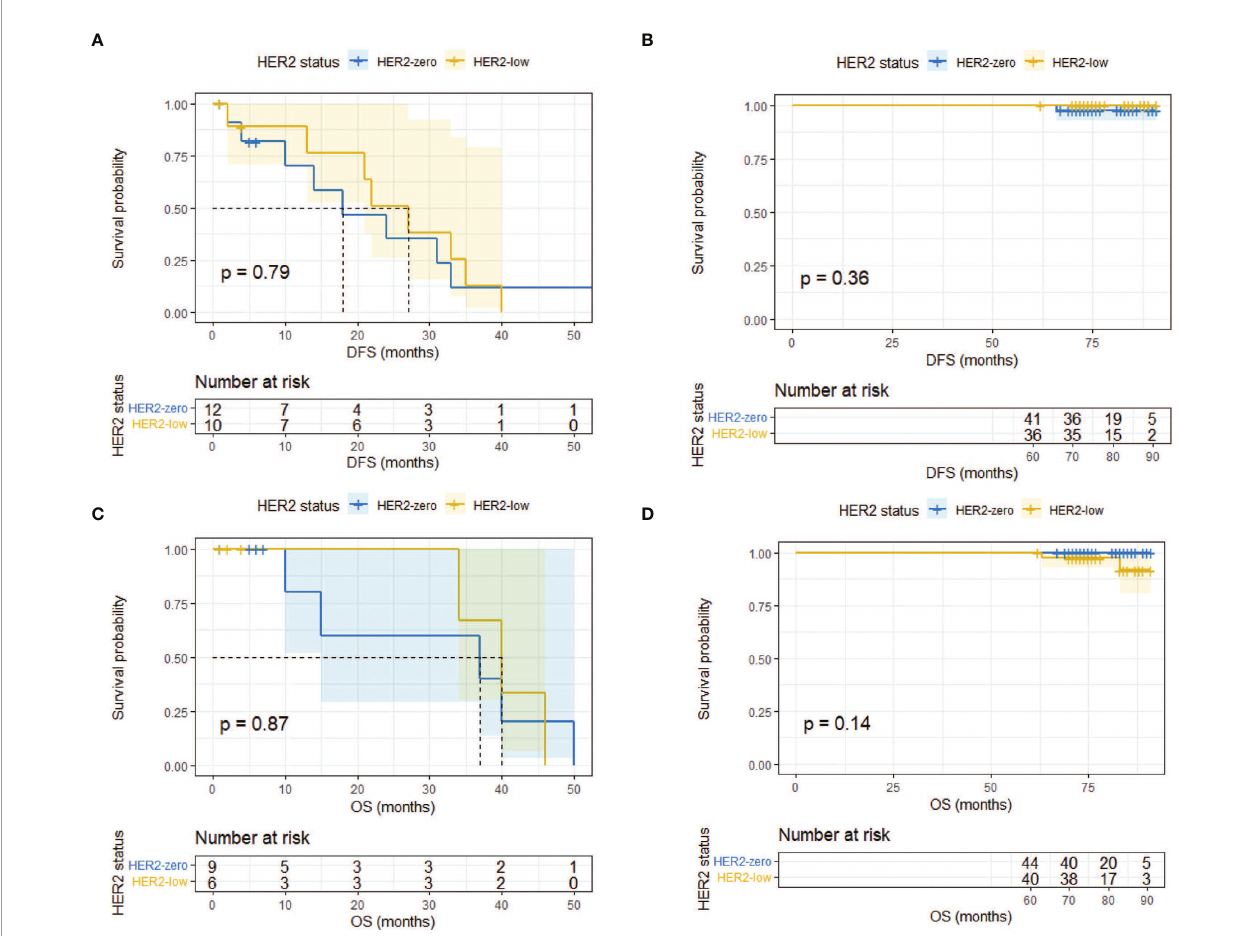
FIGURE 5 | Landmark analysis of DFS and OS in HR-negative/HER2-zero and HR-negative/HER2-low patients. (A) DFS in HR-negative/HER2-zero and HR- negative/HER2-low patients within 60 months. (B) DFS in HR-negative/HER2-zero and HR-negative/HER2-low patients after 60 months. (C) OS in HR-negative/ HER2-zero and HR-negative/HER2-low patients within 60 months. (D) OS in HR-negative/HER2-zero and HR-negative/HER2-low patients after 60